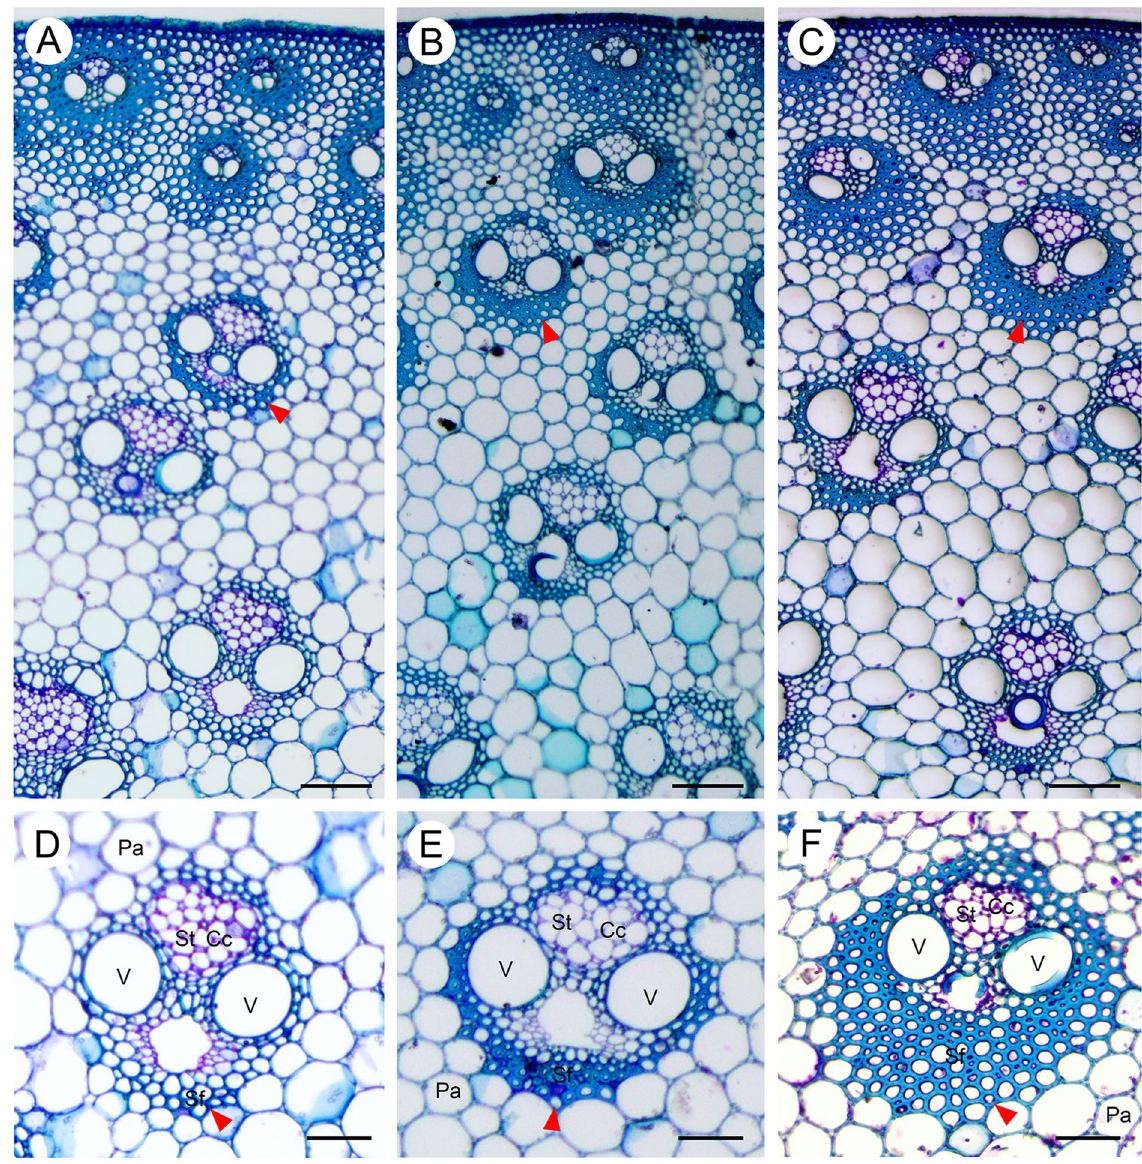
Figure 1. Anatomy of an elongating internode of M. lutariorioparius . Sections from three segments of the 2 nd internode from top were stained with Toluidine Blue O and observed under bright field. ( A ) upper internode (UI), ( B ) middle internode (MI), ( C ) basal internode (BI), ( D , E and F ) represent the magnified view of a vascular bundle in A, B, and C, respectively. Arrow head indicates the thickened fiber cells. Cc, companion cells, Pa, parenchyma, Sf, sclerenchyma fiber, St, sieve tube, V, vessel. Scale bar 100 μ m in ( A–C ), and 50 μ m in ( D – F